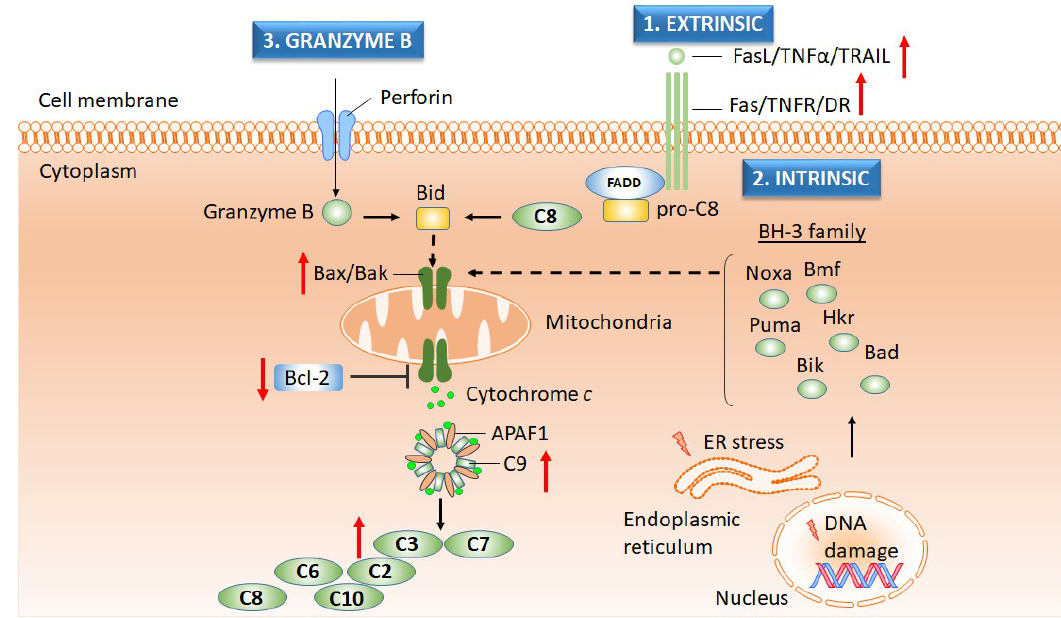
Figure 5. Apoptosis can be modulated by the activity of polyphenols in prostate cancer. Induction of apoptosis takes place through three main mechanisms: extrinsic, intrinsic, and perforin/granzyme pathways [145]. In the extrinsic pathway, activation of transmembrane death receptors (Fas/TNFR/DR) by their ligands (FasL/TNF α /TRAIL) induces the recruitment of FADD and further results in triggering of caspase-8 action. Mitochondrial release of cytochrome c , provoked by the truncated BID protein, induces the formation of the apoptosome and activation of caspase-9, which in turn activate caspase-3 and -7. The intrinsic pathway cross-talks with the extrinsic pathway at the mitochondrial level, where the BH-3 family of proteins (Noxa, Bmf, Puma, Hkr, Bik, etc.) promotes apoptosis through Bax/Bak assembly. The regulation of the apoptotic pathways is coordinated by the Bcl-2 family of proteins, which consists of both pro-apoptotic members (Bax, Bak) and anti-apoptotic members (Bcl-2). The cytotoxicity mediated by immune cells (i.e., cytotoxic T lymphocytes) occurs through pore formation in the membrane of the target cells. This pore can be formed with the help of pore-forming proteins (perforin) and is used to deliver proteases (granzymes), which in turn will trigger the apoptotic pathway [145,153]. The pro-apoptotic molecules that are upregulated by polyphenols in prostate cancer are caspase-3 (apigenin, gallic acid, gingerol, EGCG, quercetin), caspase-8 (apigenin, gallic acid, EGCG, quercetin), caspase-9 (apigenin, gallic acid, EGCG, quercetin), cytochrome c (gallic acid), Bax (apigenin, EGCG, quercetin), TRAIL (apigenin), and DR (apigenin), while the anti-apoptotic molecules that are downregulated are Bcl-2 (apigenin, gingerol, EGCG, and quercetin). Legend: FasL, Fas ligand; TNF α , tumor necrosis factor alpha; TRAIL, TNF-related apoptosis-inducing ligand; Fas, Fas receptor/ apoptosis antigen 1; TNFR, TNF receptor; DR, death receptor; FADD, Fas-associated death domain protein; Bcl-2, B-cell lymphoma type 2 protein; BH-3, Bcl-2 homology domain 3; Bid, BH3-interacting domain death agonist; Noxa, phorbol-12-myristate-13-acetate-induced protein 1; Bmf, Bcl-2 modifying factor; Puma, p53 upregulated modulator of apoptosis/ Bcl-2 binding component-3; Hkr, harakiri death protein; Bik, Bcl-2 interacting killer; Bad, Bcl-2 antagonist of cell death; Bax, Bcl-2-associated X protein; Bak, Bcl-2-antagonist/killer-1; ER, endoplasmic reticulum; upregulation (red ↑ ); downregulation (red ↓ ); schematic diagram was performed with Biomedical PPT Toolkit Suite, Motifolio, Inc., Ellicott Citty, MD, USA. Gingerol might induce apoptosis both in vitro, using PC‐3 prostate cancer cells, and in vivo, using mice with prostate cancer xenografts, by increasing the level of cleaved Poly (ADP‐ribose) polymerase (PARP) and reducing the levels of anti‐apoptotic protein Bcl‐2 [71]. EGCG, the major catechin from green tea, reduced the level of Bcl‐2, increased the level of Bax, and induced the